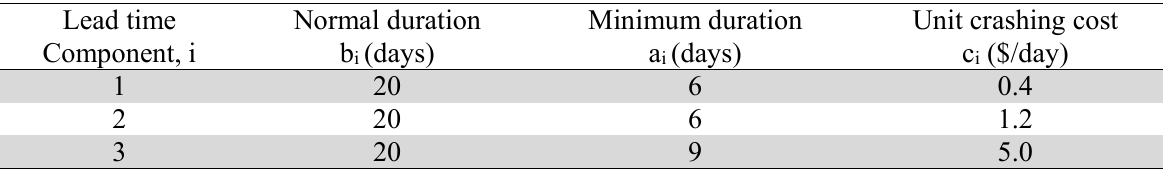
Lead time data Lead